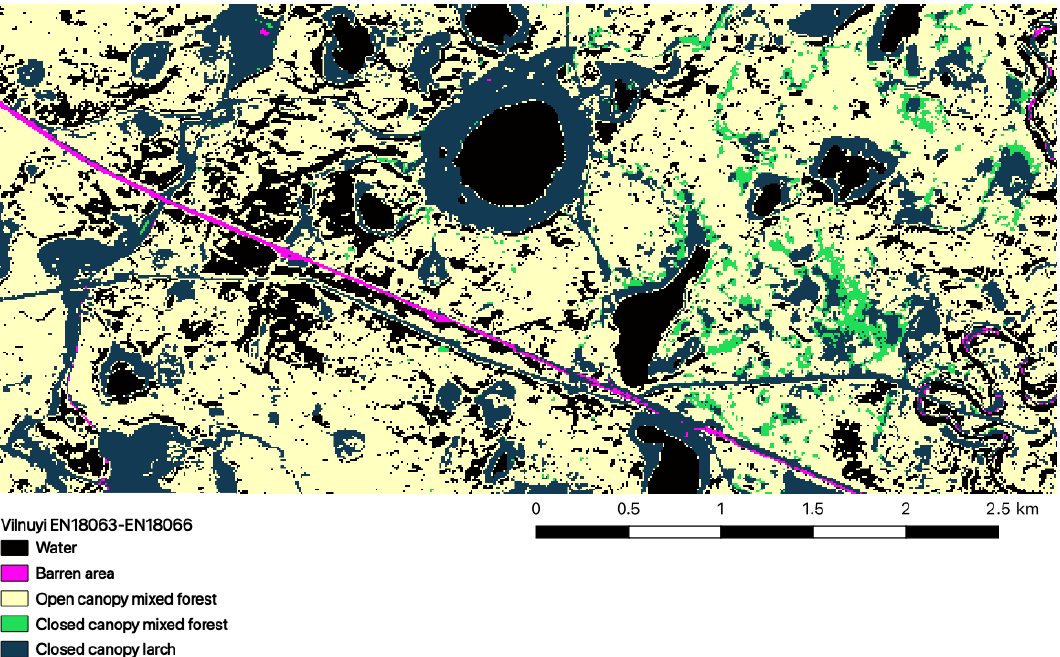
Figure 21. Classification of the Sentinel-2 Vilnuyi subregion based on the vegetation labels in SiDroForest. This is an initial classification using a Naïve Bayes algorithm with additional classes: water and barren areas.